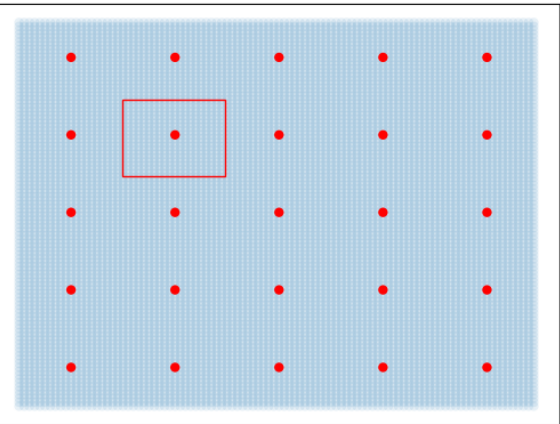
Figure 5. 2D space fractioned in a 5 × 5 grid for the perceptual experiment. The red points are the possible positions of the reference in the space, the red rectangle is the selected case.